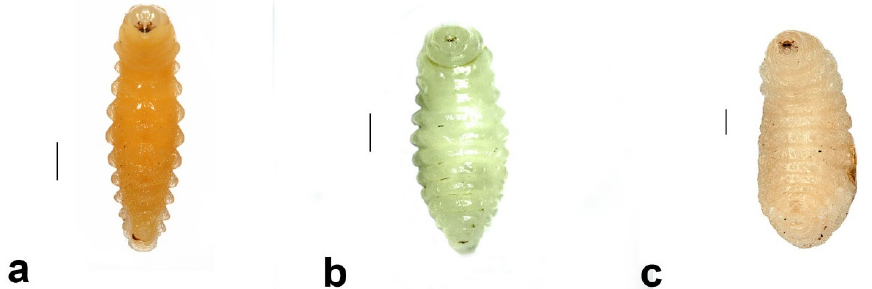
Figure 10. Larvae of secondary tenants: ( a ) larva of Pison simillimum, ( b ) larva of Hylaeus nubilosus, and ( c ) larva of Megachile aurifrons. Scale bar = 1